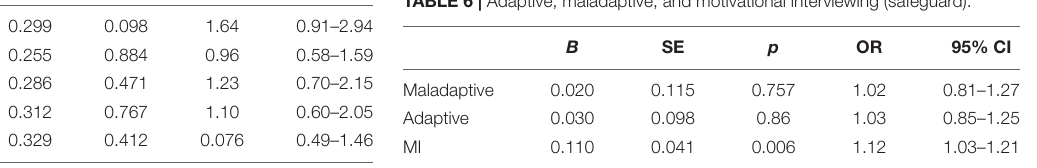
TABLE 6 | Adaptive, maladaptive, and motivational interviewing (safeguard).